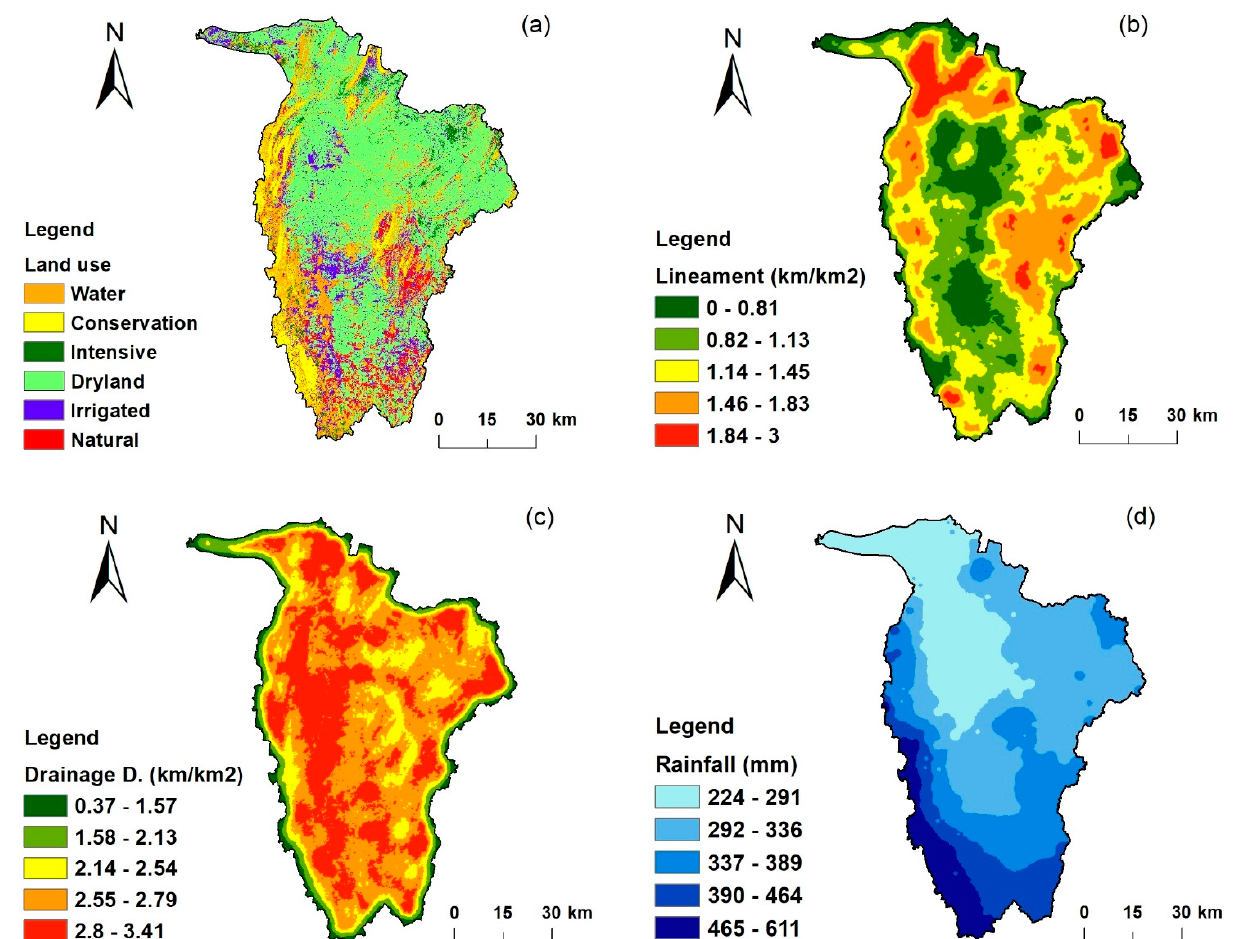
Figure 8. The thematic layers of ( a ) land use, ( b ) lineament density (km/km 2 ), ( c ) drainage density (km/km 2 ), and ( d ) rainfall (mm).